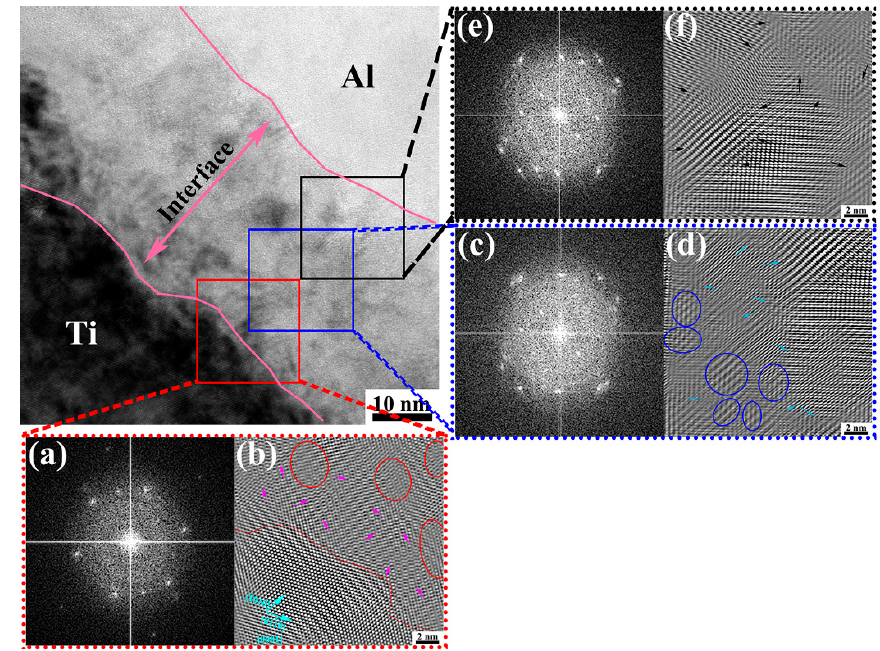
Figure 6. Analysis of the Ti–Al interface: ( a ), ( c ), ( e ) Fourier transformed pattern of the selected areas; and ( b ), ( d ), ( f ) the corresponding inverse Fourier transformed pattern of the selected areas.